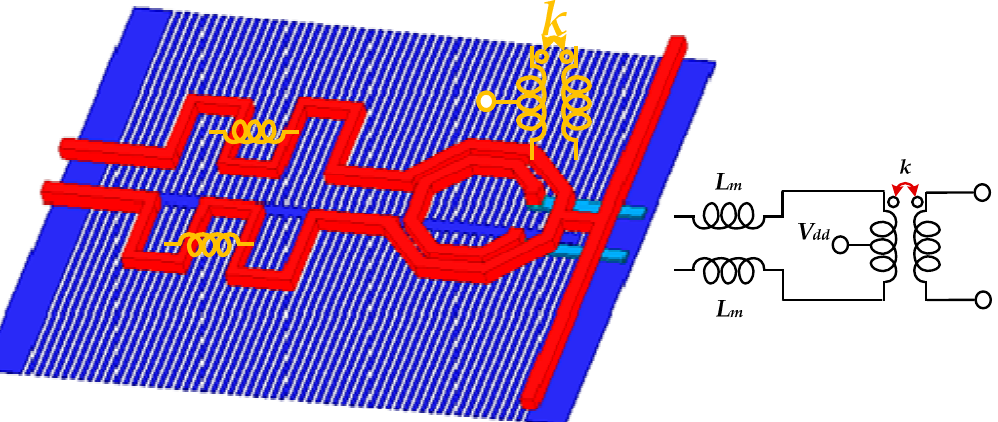
Figure 10. The layout of the matching networks and its equivalent model.